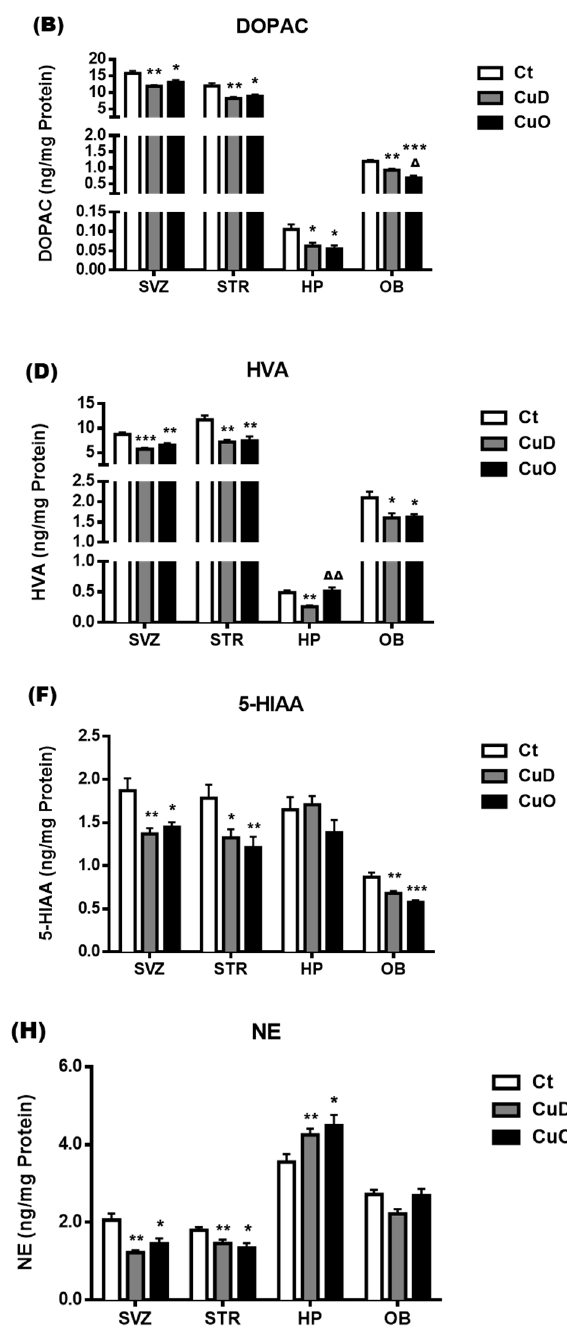
Figure 7. Changes of monoamine levels in selected brain regions following CuD or CuO treatment. Brain monoamine levels were assayed by HPLC. ( A ). Brain regional DA levels. ( B ). Brain regional DOPAC levels. ( C ). DA turnover in different brain regions. ( D ). Brain regional HVA levels. ( E ). Brain regional 5-HT levels. ( F ) Brain regional 5-HIAA levels. ( G ). 5-HT turnover rates in different brain regions. ( H ). Brain regional NE levels. Data represents mean ± SEM, n = 6–7/group. *: p < 0.05, **: p < 0.01, *** p < 0.001, as compared with the correspondent Ct group; ∆ : p < 0.05, ∆∆ : p < 0.01, as compared with the correspondent CuD group; using one-way ANOVA analysis. Ct: control; CuD: Cu deficiency; CuO: Cu overload; SVZ: subventricular zone; STR: striatum; HP: hippocampus; OB: olfactory bulb; DA: dopamine; DOPAC: 3,4-Dihydroxy- phenylacetic acid; HVA: homovanillic acid; 5-HT: 5-hydroxytryptamine or serotonin; 5-HIAA: 5-hydroxyindoleacetic acid; NE: norephinephrine.